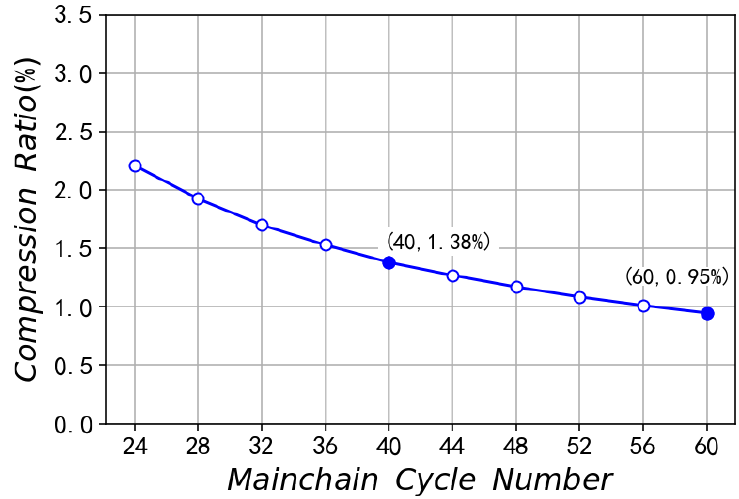
Figure 13. The compression ratio (world state creation and update transactions).